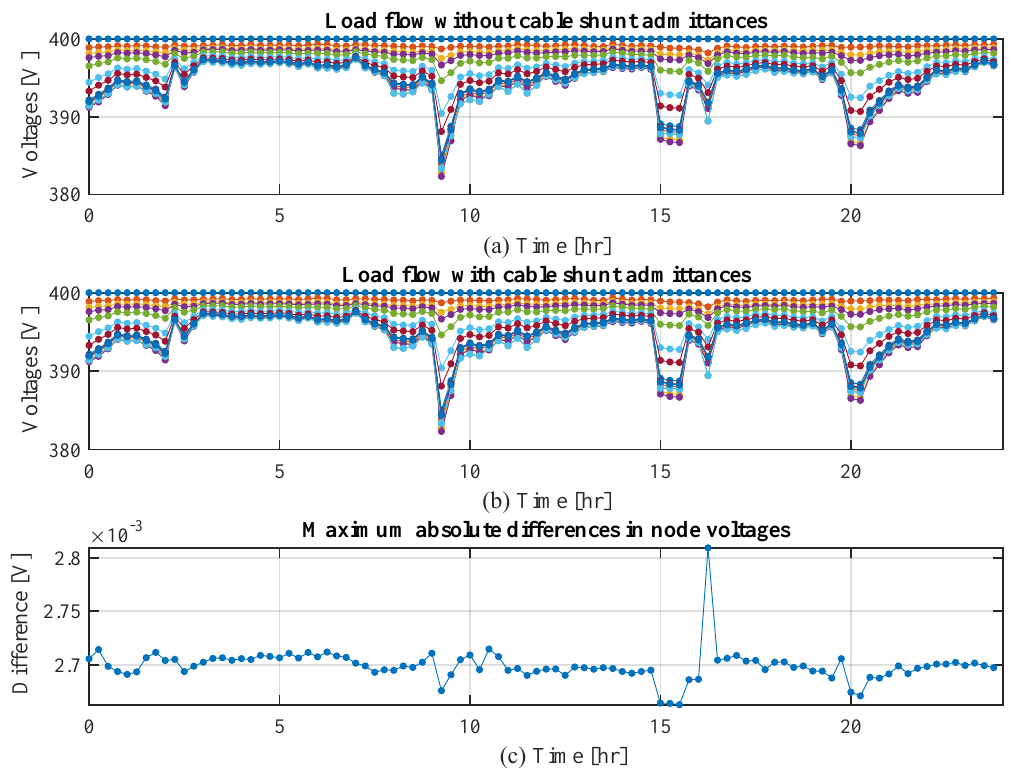
Figure 6. Plot of node voltages obtained from load flow results ( a ) without including cable shunt admittances and ( b ) with cable shunt